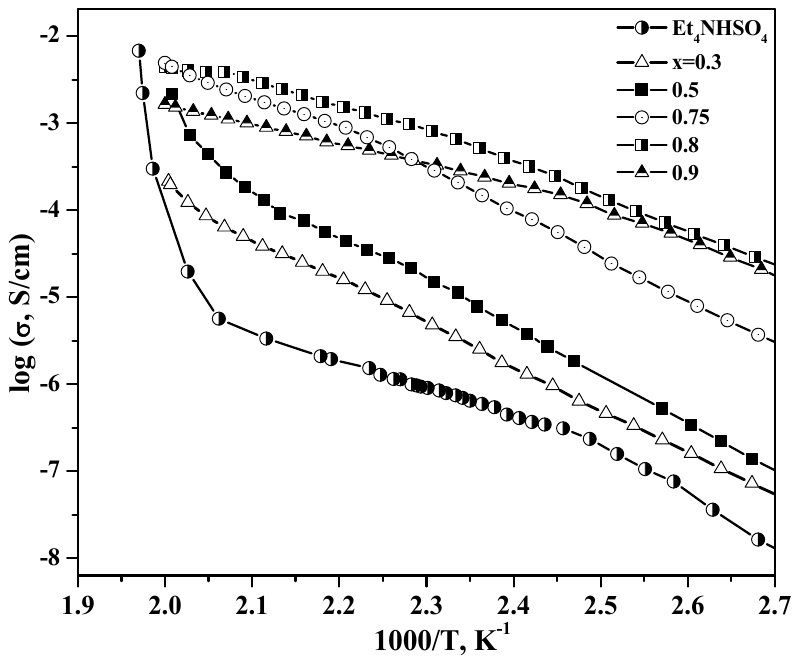
Figure 8. Temperature dependencies of conductivity of Et 4 NHSO 4 and (1 – x)Et 4 NHSO 4 –xSiO 2 with different compositions, x = 0.5–0.9 (cooling regime, air, 0.5–1 deg/min).